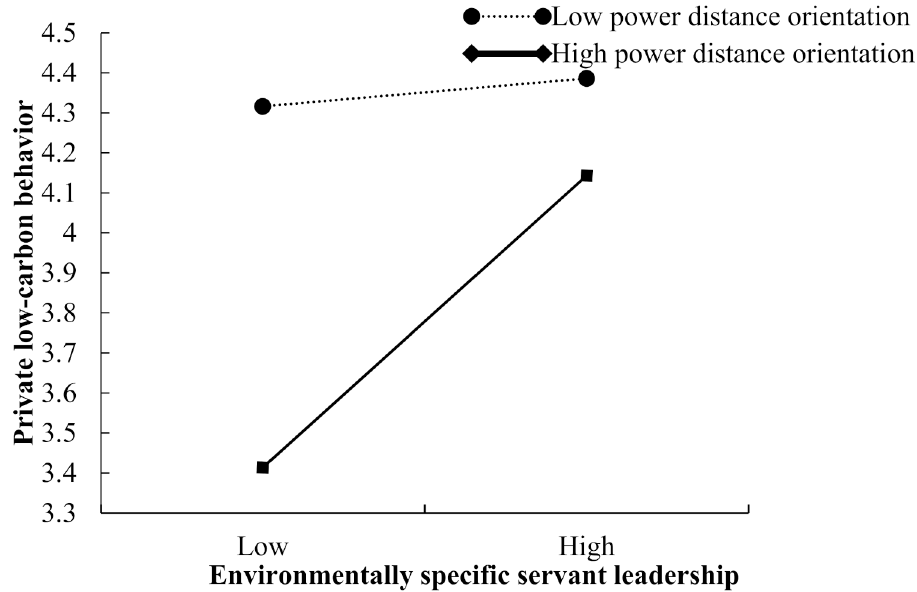
Figure 3. The moderating effect of power distance orientation on the relationship between environ- mentally specific servant leadership and private low-carbon